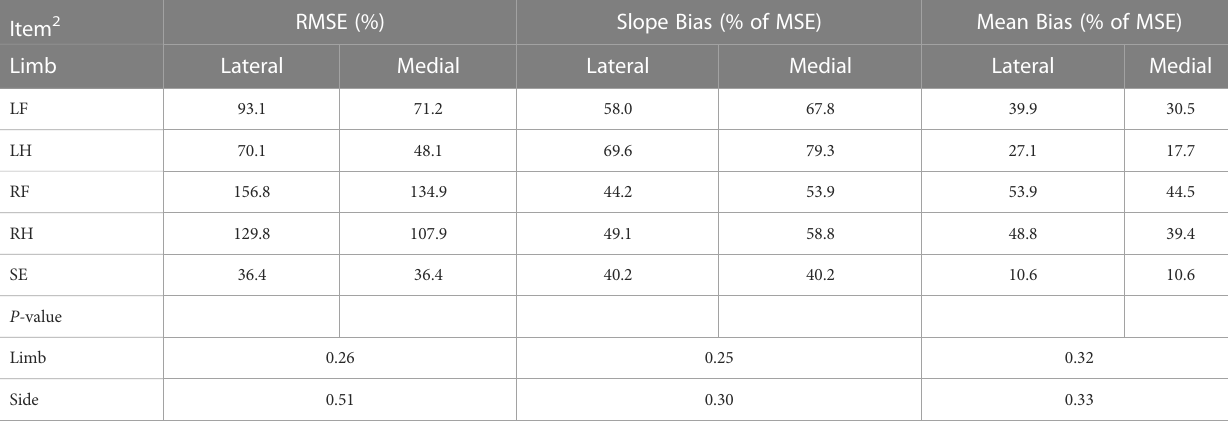
TABLE 2 Fit statistics for the comparison of sensor-measured heart rates and heart rates determined manually when strati fi ed by limb and positioning on the limb 1 . Item 2 RMSE (%) Slope Bias (% of MSE) Limb